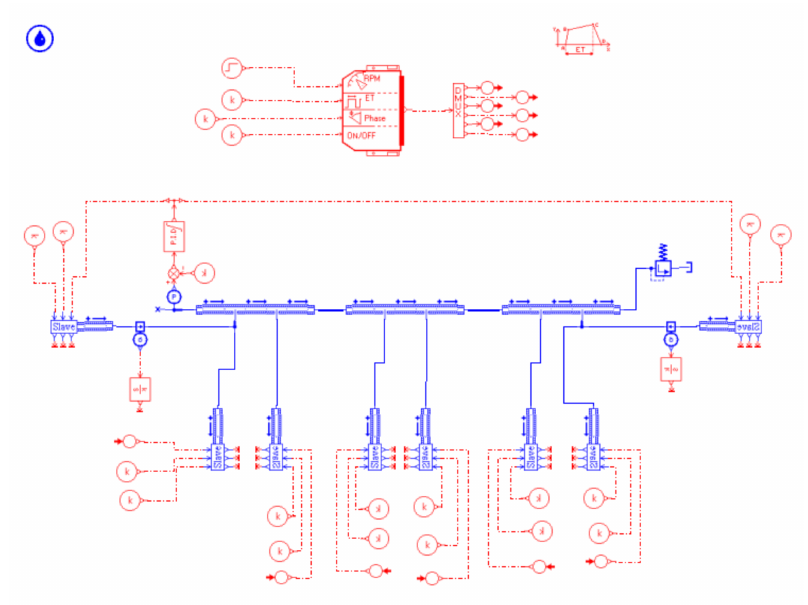
Figure 4. Performance simulation of a high-pressure common rail fuel